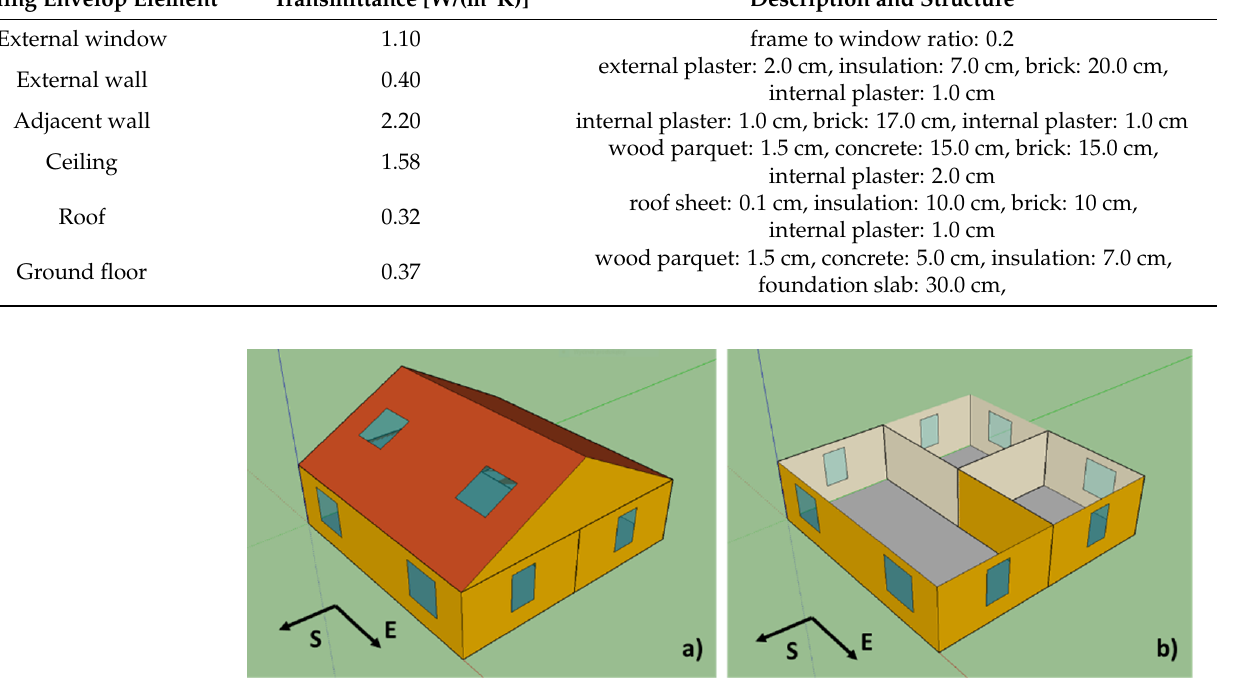
Table 2. Building envelop elements thermal transmittance and structure.